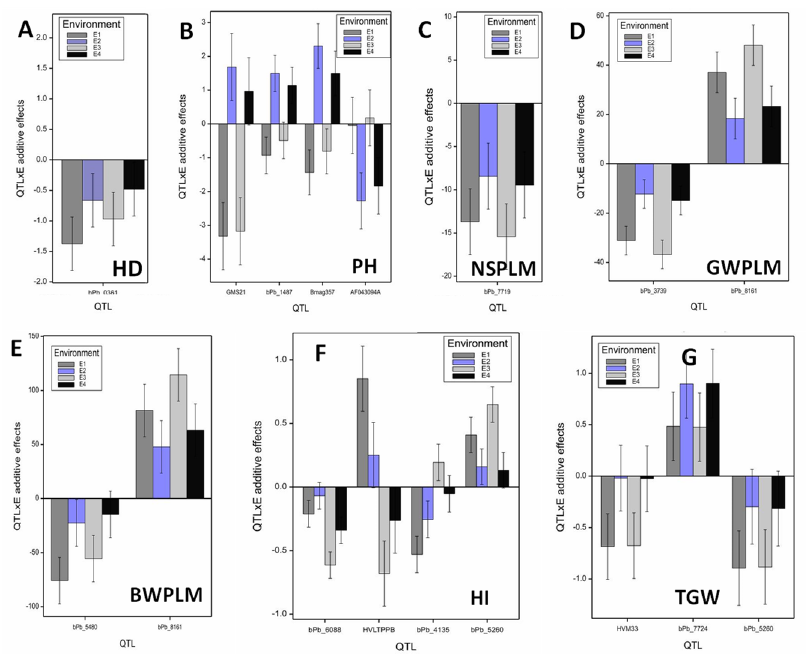
Figure 2. Detected QTL for measured traits that showed QTL by environment additive interaction under salinity conditions. Where ( A ) Heading date (HD), ( B ) Plant height (PH), ( C ) Number of spikes lm − 1 (NSPLM), ( D ) Grain weight lm − 1 (GWPLM), ( E ) Biological weight lm − 1 (BWPLM), ( F ) Harvest index (HI), and ( G ) Thousand grain weight (TGW).